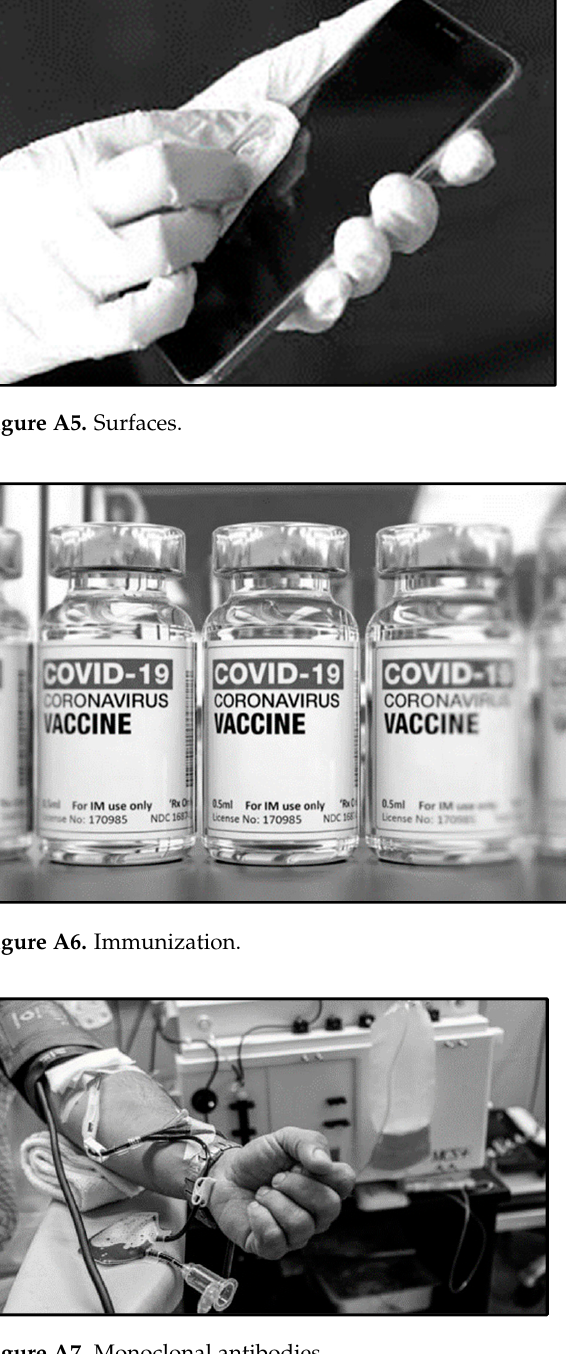
Figure A7. Monoclonal antibodies.